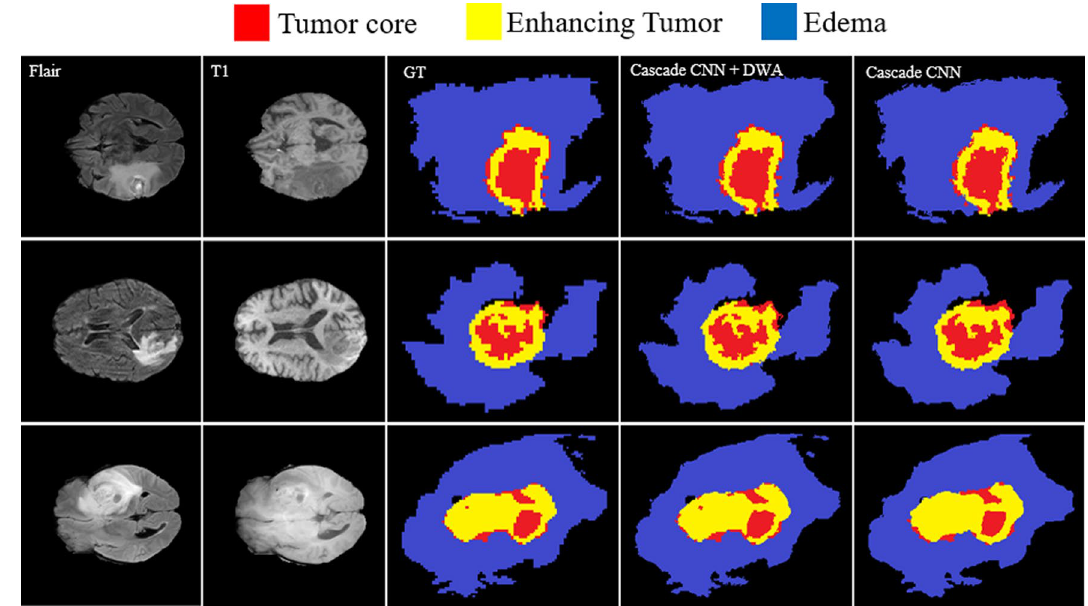
Figure 14. Comparing the results of brain tumor segmentation by applying DWA method to the proposed CNN structure. The blue, yellow, and red colors are edema, enhanced, and core regions respectively.